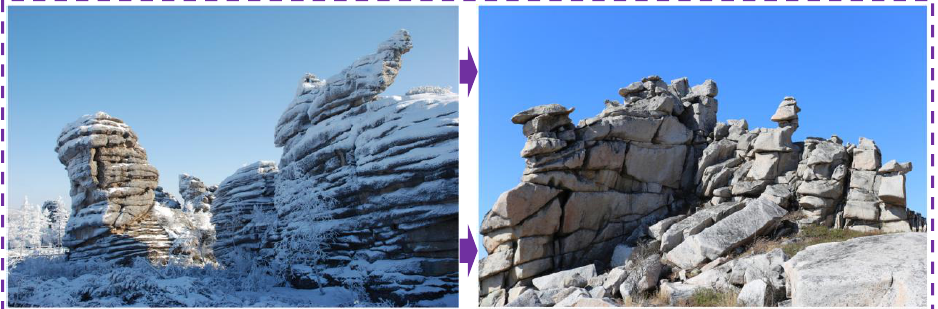
Figure 1. Macroscopic damage and deterioration of jointed rock masses under freeze–thaw shear in northeast China.